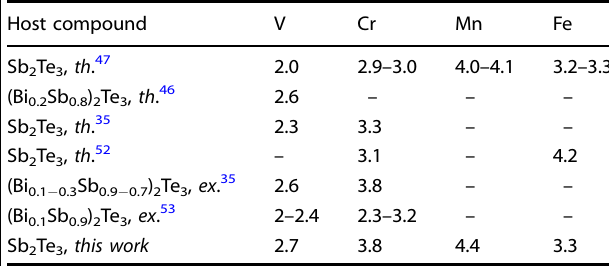
Table 1. Spin moments in μ B of 3 d transition metal doped Sb 2 Te 3